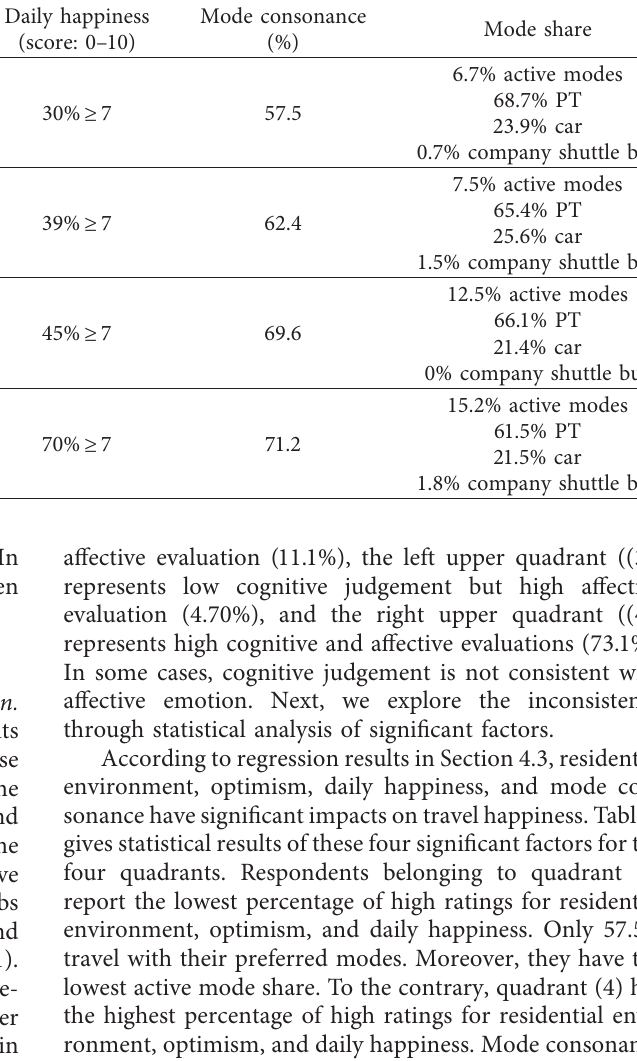
Table 6: Statistical results of main significant factors for four